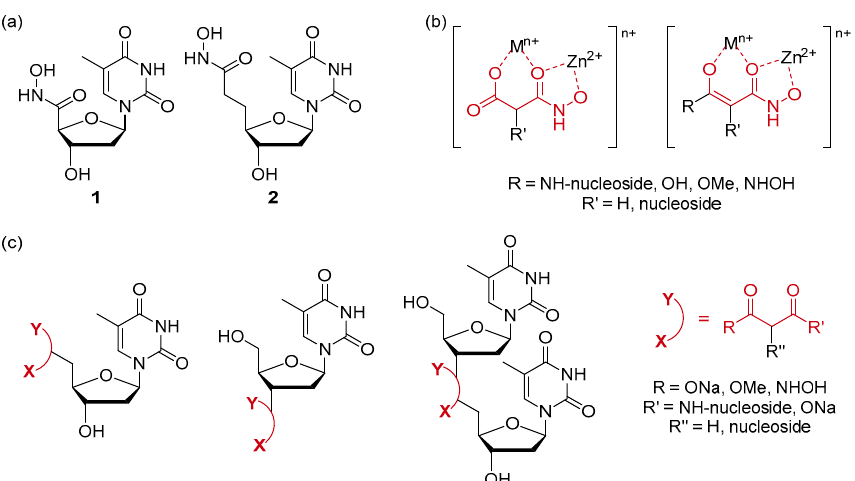
Figure 1. Design of modified nucleosides designed to bind to SNM1A. ( a ) Previously reported nucleoside inhibitors of SNM1A; ( b ) the proposed binding mode for hydroxamic acid malonate derivatives; ( c ) structures of target (di)nucleosides.